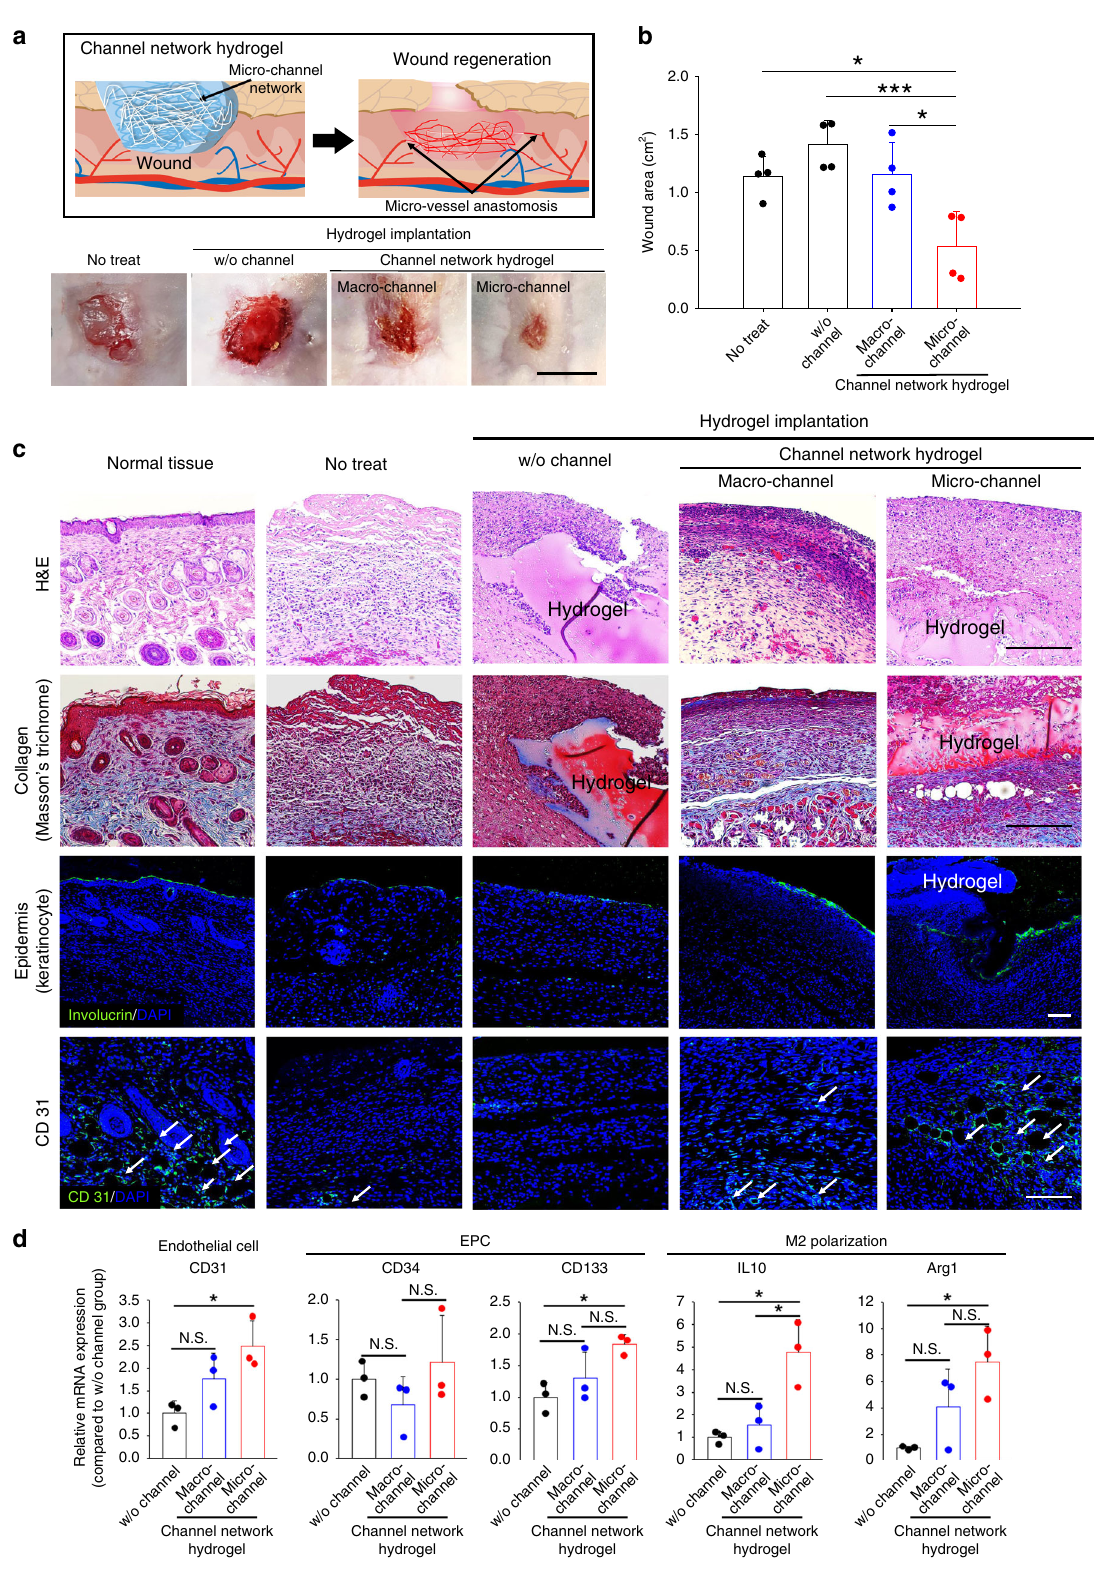
mesh, and 3D printing was not able to reach suf fi cient resolution for producing the closed network of dense fi bers 41,42 . Only a cotton candy machine-like production of sacri fi cial fi bers enabled nutrient diffusion limits to be overcome, which was a game- changer in this approach 43,44 . The use of enzyme